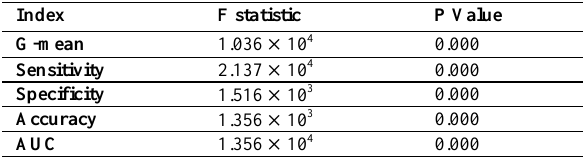
Table 7. F Statistic and P value of ANOVA test for all indices.